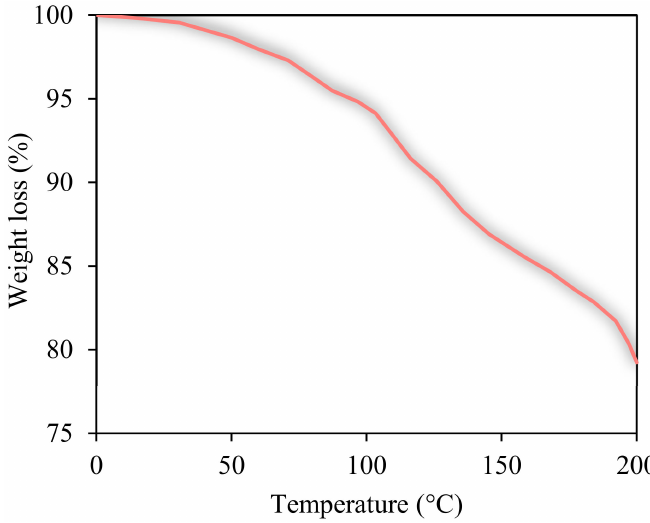
Figure 5. Thermogravimetric analysis of the AGC extracted from